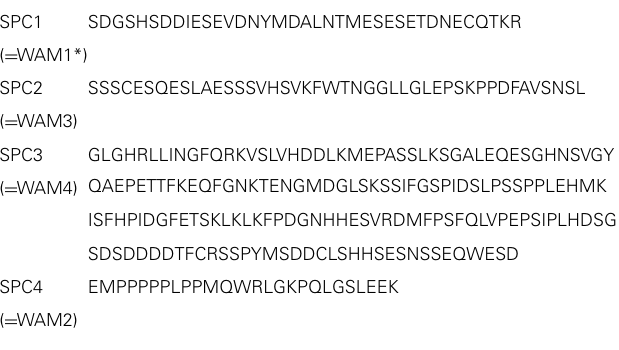
Table 1 |Amino acid sequences used for motif search in plant